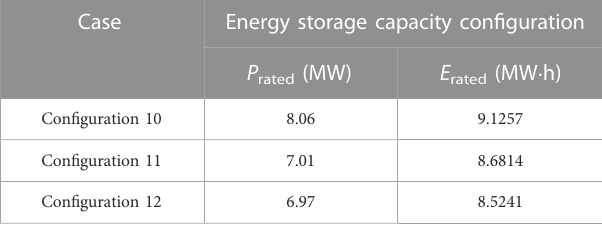
TABLE 9 Energy storage capacity con fi guration without considering SFD.